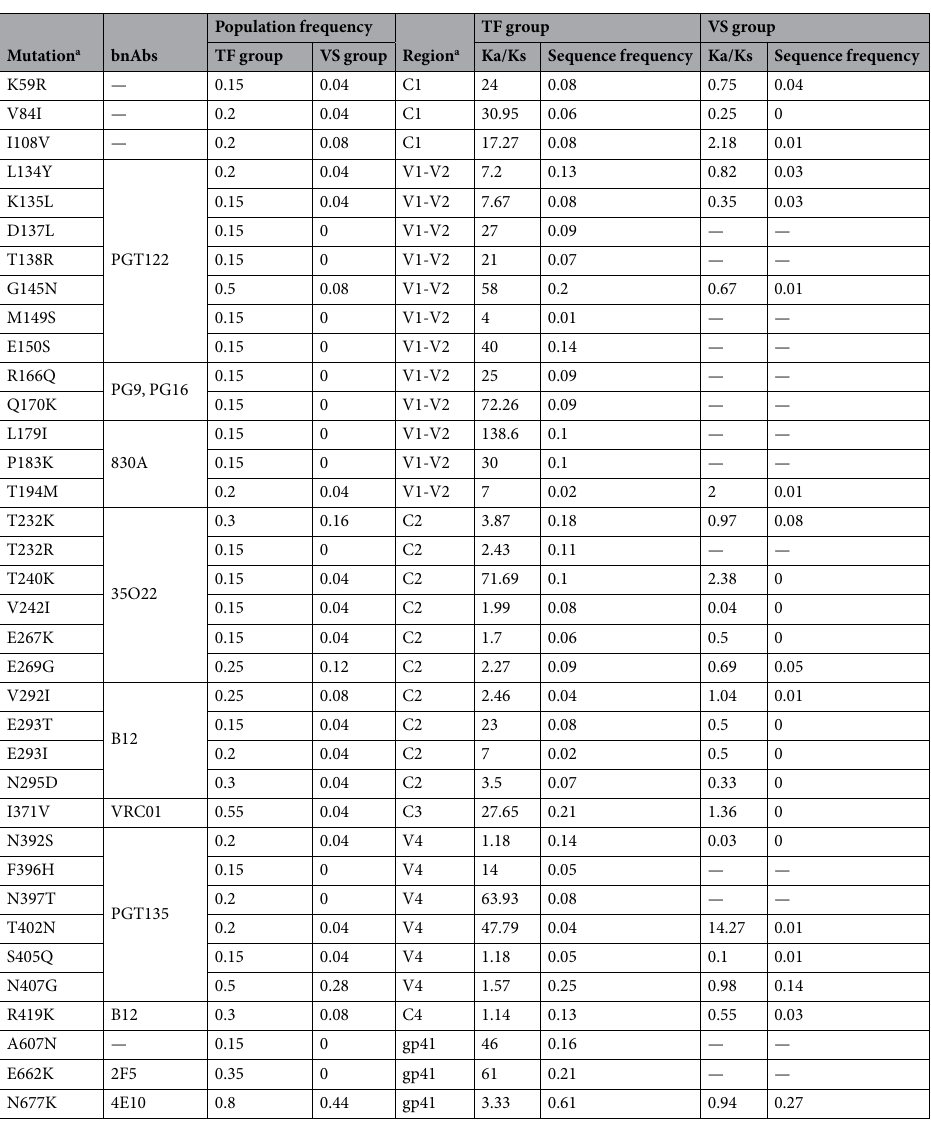
Table 2. Therapy failure-related adaptive mutations. a HXB2 Env was used as a reference sequence.—: no associated